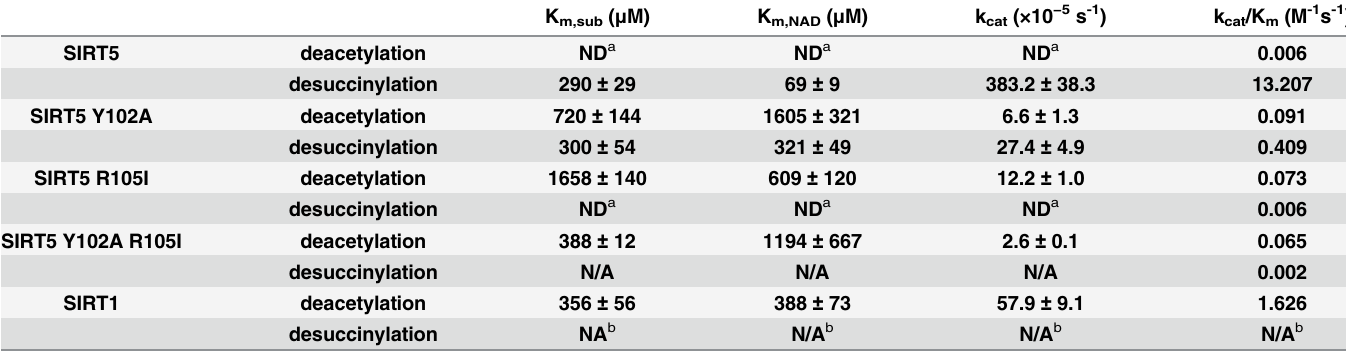
Table 2. Steady-state Kinetic Parameters of SIRT5 Variants and SIRT1 on Acetyl and Succinyl